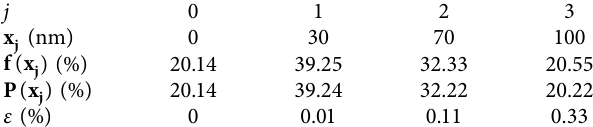
Table 2: Errors obtained by Lagrange polynomial approximation.